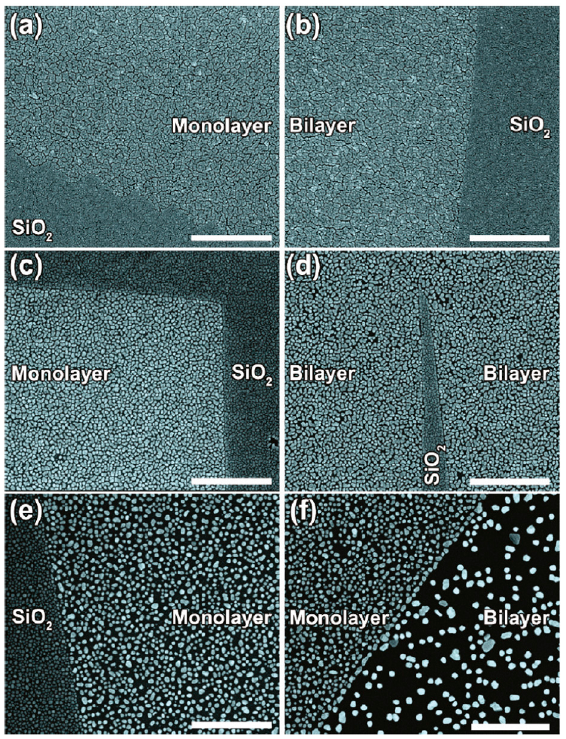
Figure 26. Scanning Electron Microscopy images (1 µ m scale bar) of monolayer and bilayer graphene on SiO 2 after deposition of 5 nm Ag maintaining the substrate at different temperature during the deposition: ( a , b ) 298 K; ( c , d ) 333 K; ( e , f ) 373 K. Reproduced from Reference [71] with permission from the American Chemical Society.